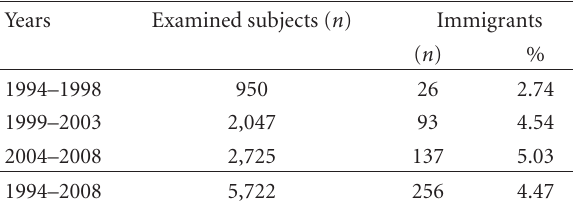
(b) Molecular tests for definitive diagnosis (carriers and a ff ected individ-